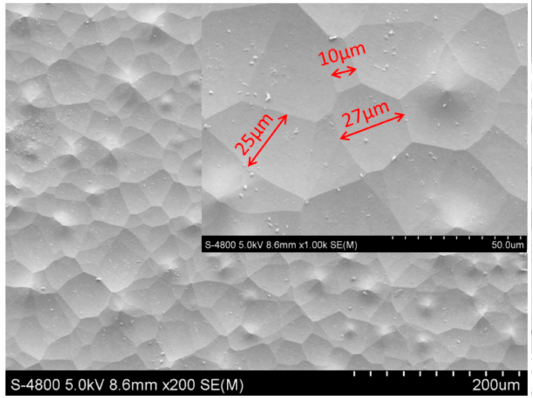
Figure 5. Micrograph of the microwell